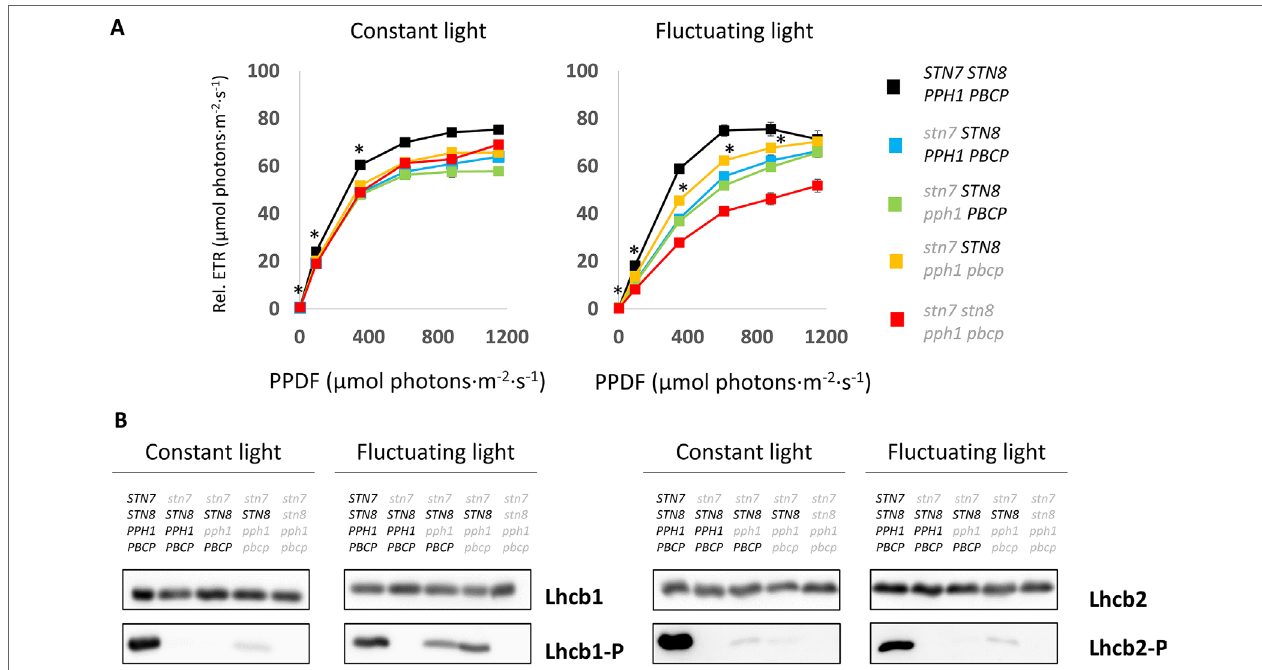
FIGURE 6 | Photosynthetic efficiency and LHCII phosphorylation status upon growth under fluctuating light. (A) Electron transport efficiency Φ PSII calculated from the room temperature chlorophyll fluorescence at increasing light intensities. The test was performed in parallel on 24-day old plants grown for 14 days under constant light (100 µmol photons m −2 s −1 ) (left) and fluctuating light (4 min at 50 µmol photons m −2 s −1 and 1 min at 500 µmol photons m −2 s −1 ) (right), plants were measured individually and the average ETR is reported (error bars indicate the S.E.). Light intensities at which the triple mutant ( stn7/ STN8 /pph1/pbcp ) relative ETR is statistically different from the other mutant lines and the wild type (Student t test P < 0.05) are highlighted by an asterisk. PPFD is the photoactive photon flux density measured as µmol of photons m −2 s −1 . (B) The phosphorylation status of the two major LHCII isoforms assessed by immunodetection. The membrane blots of total protein extracts from plants grown under continuous or fluctuating light conditions were probed with antibodies against Lhcb1, Lhcb2 or their phosphorylated N-terminal peptides (Lhcb1-P or